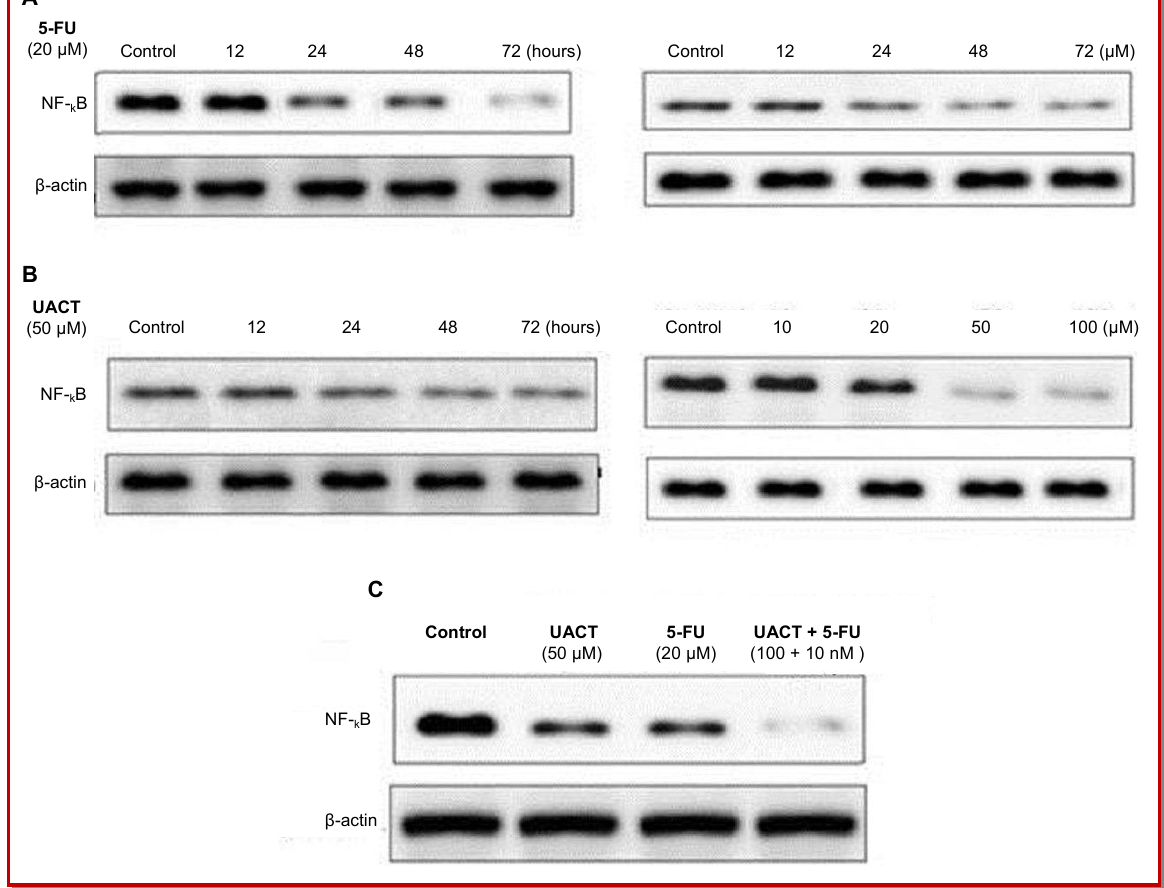
Figure 3: Effect of 5-FU and UACT on NF- k B protein expression in H209 cells (A) H209 cells were treated with 20 µM of 5-FU for indicated time (left) and a range of 5-FU concentrations for 72 hours (right). (B) H209 cells were treated with 50 µM of UACT for 72 hours (left) and a range of indicated UACT concentrations for 72 hours. (C) H209 cells were untreated or treated with 50 µM of UACT alone for 24 hours, 20 μ M 5-FU alone for 24 hours, or 100 nM of UACT for 24 hours followed by 10 μ M 5-FU for 24 hours. Total cell lysates of each treatment were subjected to Western blot analysis with an anti-NF- k B antibody as described in Materials and Methods. β -actin was used as a loading